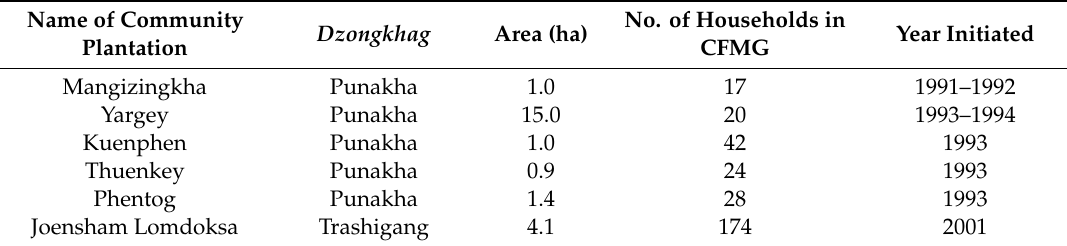
Table 1. Community plantations in selected areas with district location, area, number of households in the Community Forest Management Group (CFMG) and year planting initiated.